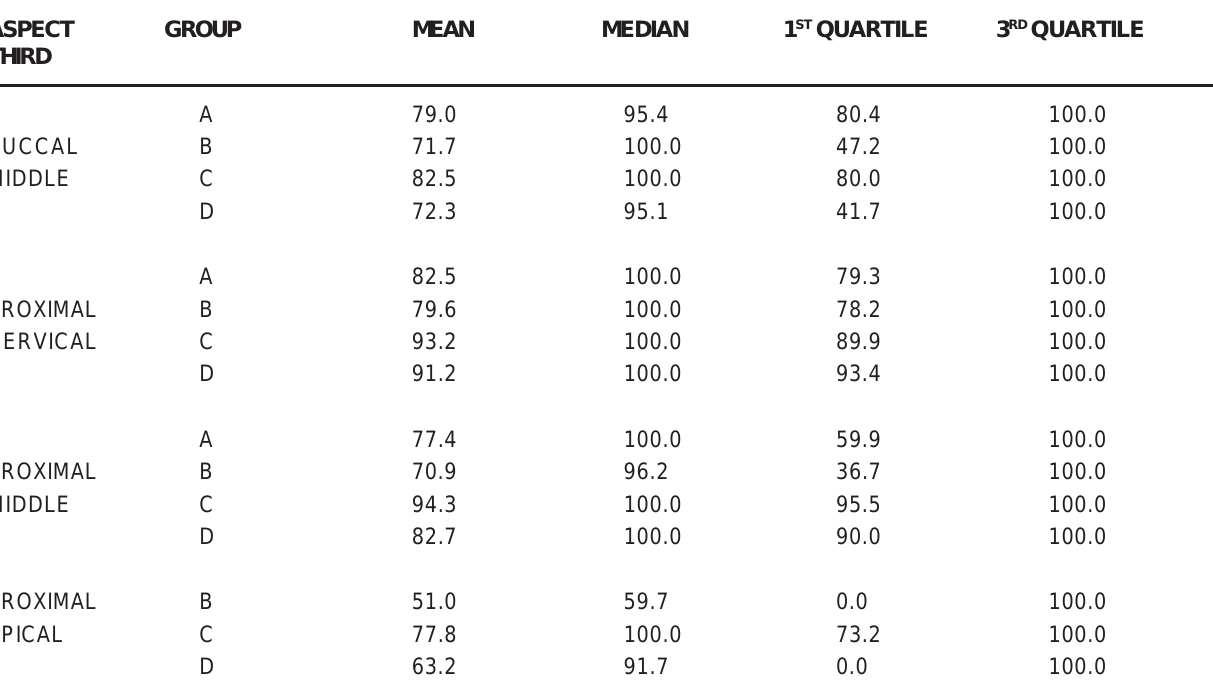
TABLE 1- Mean percentage, median, 1 st and 3 rd quartiles of penetration of the filling materials in the lateral canals in relation to their location (aspect and third) and the four experimental groups. Friedman